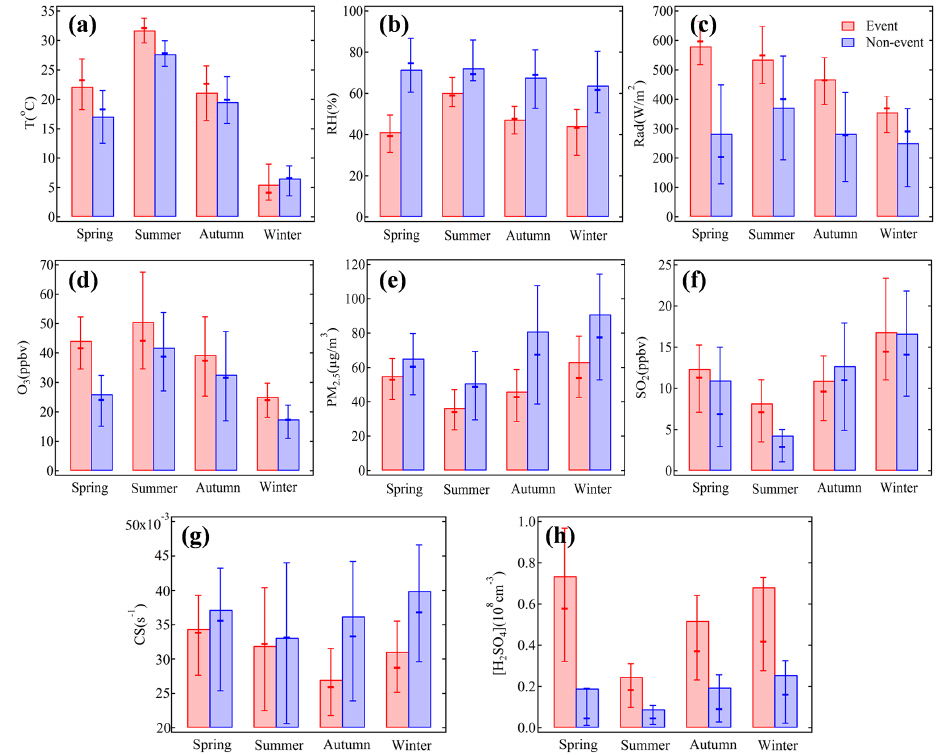
Figure 9. (a – c) Meteorological variables, (d – f) gaseous pollutants, (g) condensation sink and (h) H 2 SO 4 proxy during event (red) and non- event (blue) days in different seasons. Note: bars are the mean value. The bold sticks and whiskers indicate the median values and the 25th and 75th percentiles, respectively.